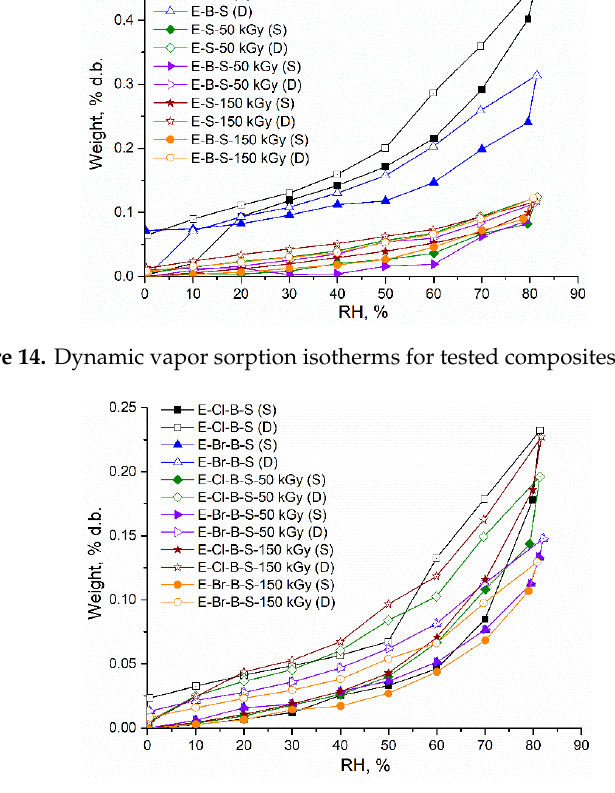
Figure 15. Dynamic vapor sorption isotherms for tested composites E-Cl-B-S; E-Br-B-S. Table 7. Main data evaluated from sorption isotherms of tested samples.